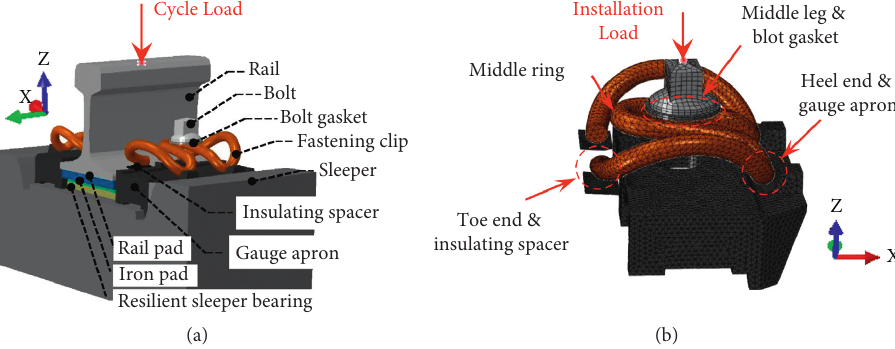
Figure 5: A FE model of the Vossloh 300-1 fastener system: (a) the configuration of the fastener system; (b) locations of the point-to-surface nonlinear contacts.